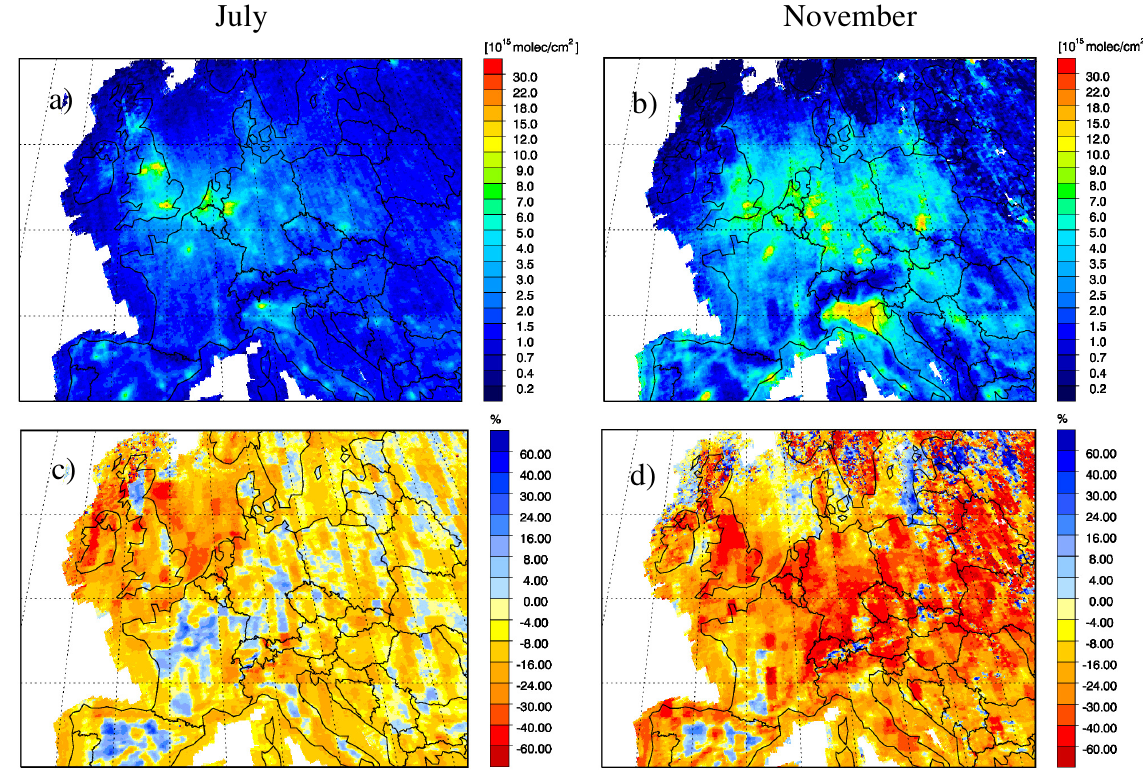
Fig. 12. Mean NO 2 VTCs averaged over 2006 and 2007 retrieved with TOMS/GOME LER data for (a) July and (b) November, and Fig. 11: Mean NO VTCs averaged over 2006 and 2007 retrieved with TOMS/GOME LER 2 corresponding mean relative differences from NO BRDF shown in Fig. 10 in July (c) and November (d) 2 data for (a) July and (b) November, and corresponding mean relative differences from NO 2BRDF shown in Fig. 10 in July (c) and November (d).